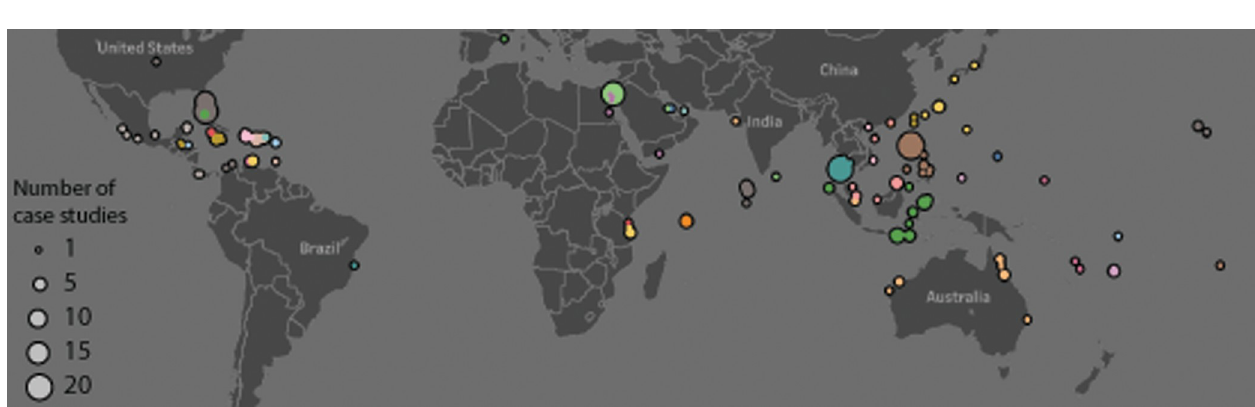
Fig 1. Location of coral restoration case studies included in the review. Restoration case studies occur in 56 countries, with most countries that have substantial coral reef area having at least one case study. Data points are coloured by